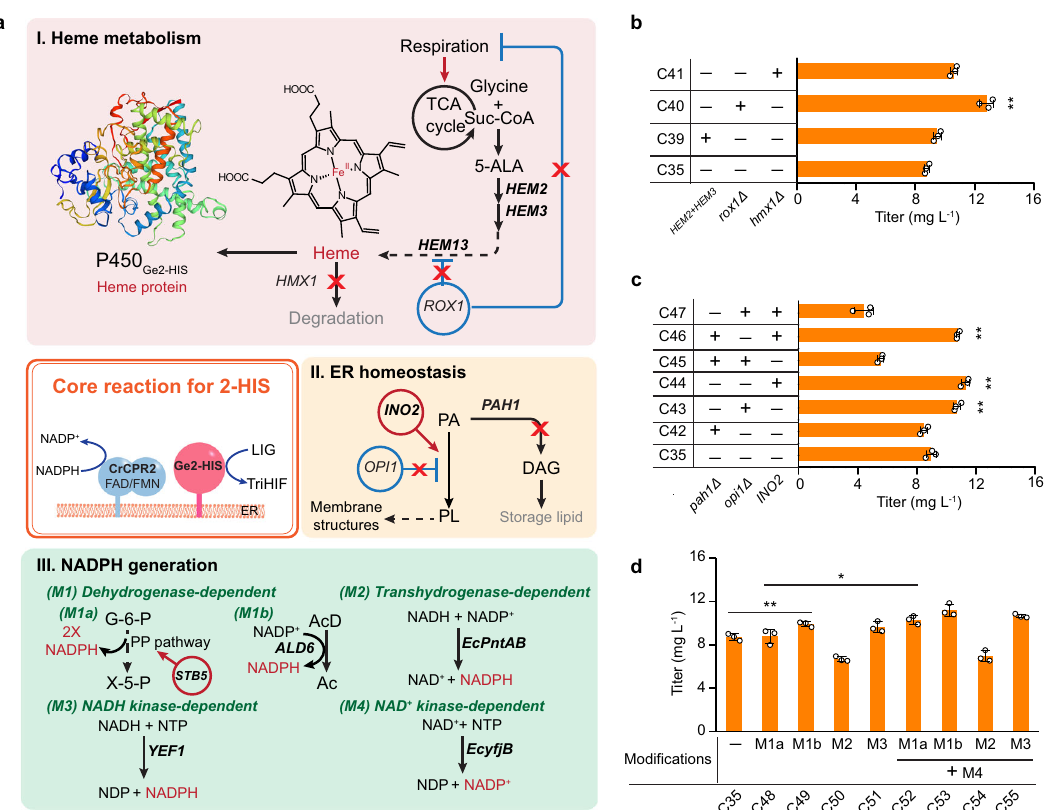
Fig. 4 Investigation of metabolic factors affecting DEIN biosynthesis. a Schematic illustration of the genetic modi fi cations performed to relieve potential metabolic limitations, regarding heme metabolism (I), ER homeostasis (II), and cofactor NADPH generation (III), to improve the performance of P450 Ge2- HIS. Overexpressed genes are shown in bold and gene deletion is marked with a red cross. Red circle and arrows, transcriptional factors (TFs) activating a metabolic gene/pathway; Blue circle and fl at-head arrow, TFs repressing a metabolic gene/pathway. HEM2 , 5-aminolevulinic acid dehydratase; HEM3 , 4-porphobilinogen deaminase; HEM13 , coproporphyrinogen III oxidase; ROX1 , heme-dependent repressor of hypoxic genes; PAH1 , phosphatidate phosphatase; INO2 / OPI1 , transcription activator/repressor of phospholipid biosynthetic genes; ALD6 , cytoplasmic NADP + -dependent aldehyde dehydrogenase; EcpntAB , membrane-bound transhydrogenase from E. coli ; YEF1 , ATP-NADH kinase. Suc-CoA, succinyl-CoA; PA, phosphatidic acid; PL, phospholipid; DAG, diacylglycerol; X-5-P, xylulose-5-phosphate; AcD, acetaldehyde; Ac, acetate; NTP, nucleoside triphosphates; NDP, nucleoside diphosphates. See Fig. 1 and its legend regarding abbreviations of metabolites and other gene details. Production of DEIN by engineered yeast strains derived from strategy groups I ( b ), II ( c ), and III ( d ), respectively. Cells were grown in a de fi ned minimal medium with 30 g L − 1 glucose as the sole carbon source, and cultures were sampled after 72 h of growth for metabolite analysis. Statistical analysis was performed by using Student ’ s t test (two-tailed; two-sample unequal variance; * p < 0.05, ** p < 0.01, *** p < 0.001). All data represent the mean of n = 3 biologically independent samples and error bars show standard deviation. The source data underlying panels ( b − d ) are provided in a Source Data fi P450RhF from Rhodococcus sp. strain NCIMB 9784 36 ; and (3) RhF-fdx, a hybrid reductase by substituting Fe 2 S 2 domain of